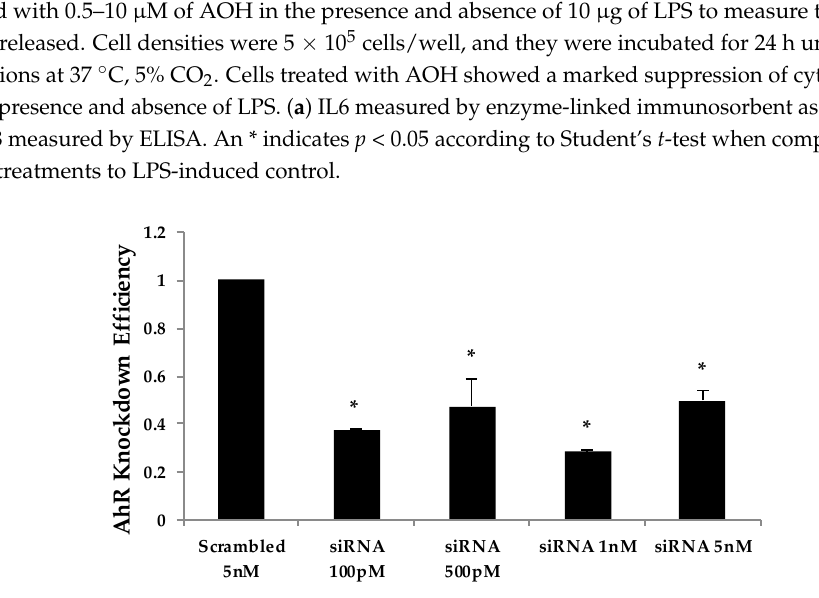
Figure A2. Quantitiatve real-time reverse transcription polymerase chain reaction (qRT-PCR) analysis of doses for aryl hydrocarbon receptor (AhR) silencing. Cells were seeded with a density of 150,000 cells/well. Cells were treated with AhR siRNA for 24 h. A dose curve was performed to elucidate the concentration required for AhR silencing in lung epithelial cells BEAS-2B. An * indicates p < 0.05 according to Student’s t -test for AhR-specific siRNA treatments compared to the scrambled siRNA control.